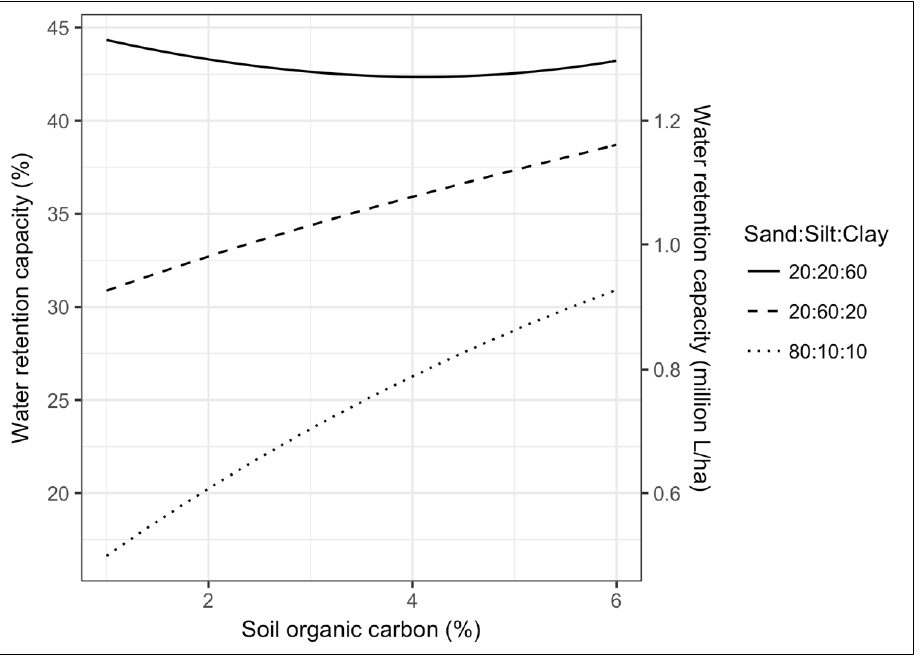
Figure 1: Modelled relationship between soil organic carbon (%) and water retention (%) using the